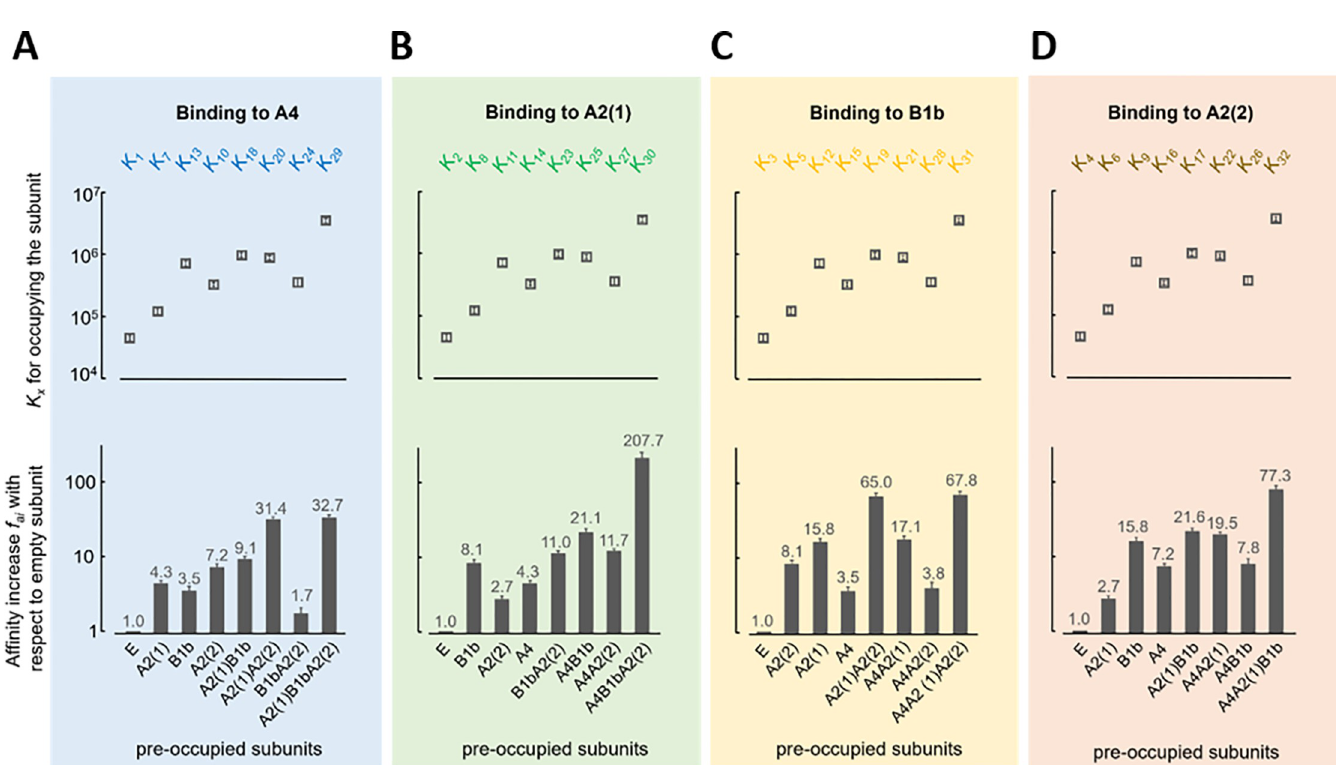
Fig 3. Effects of pre-occupied subunits on ligand binding. ( A - D ) Equilibrium association constants for the closed channel, K many times the affinity of a subunit is increased by pre-occupation of the other subunits with respect to the same subunit in the empty channel, for A4, A2(2), B1b, and A2(1). ‘E’ indicates the empty channel. The values correspond to S6 Table.